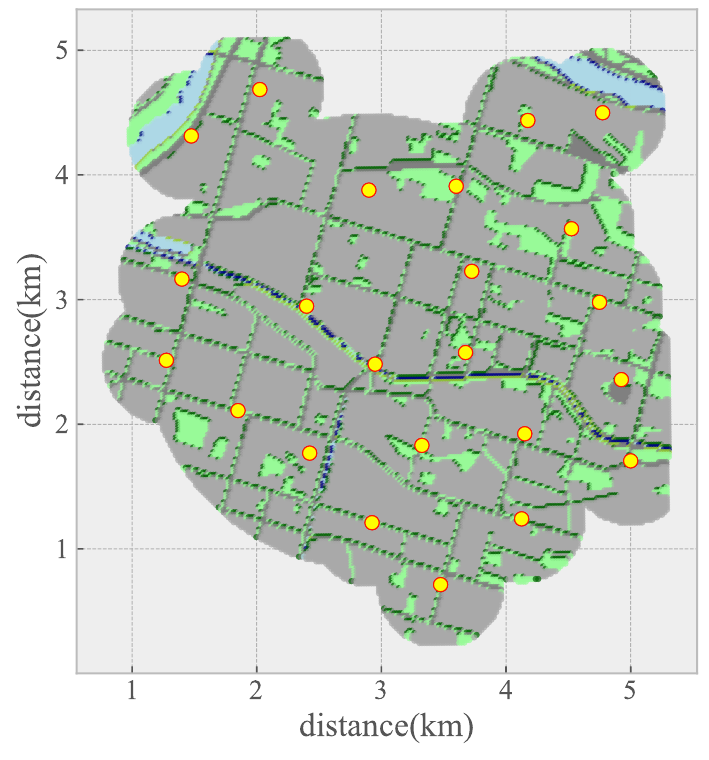
Figure 8. The actual network deployment